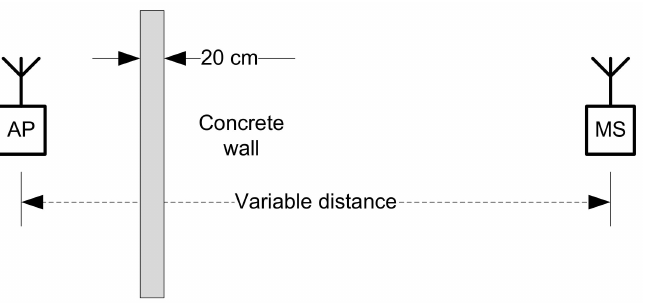
Figure 15. Test bed setup for BT signal strength indicator variation in stationary conditions—NLoS connection.